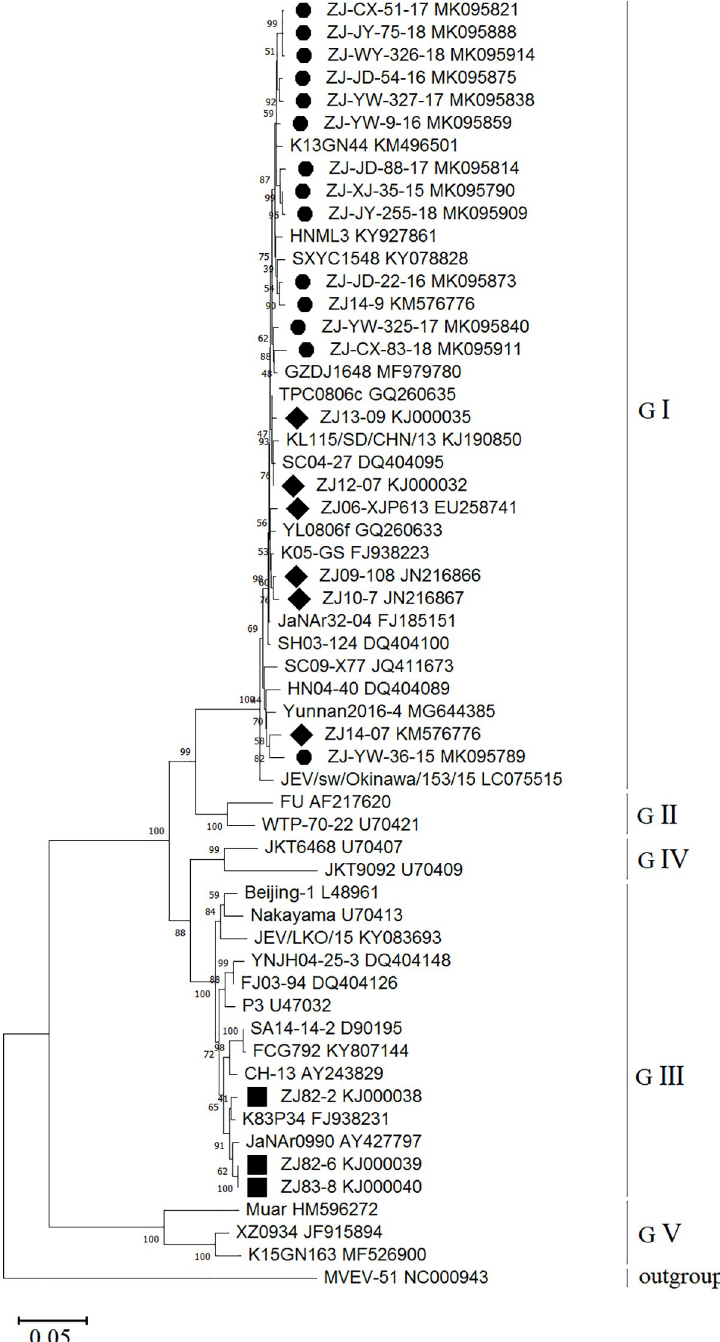
Fig 4. Phylogenetic tree on 1500-nt envelope gene of Japanese encephalitis virus strains. A total of 57 selected strains were involved in phylogenetic analysis, including 13 E gene samples (2015–2018), 10 strains (7 strains from 2006–2014 and 3 strains from 1982–1983) derived from Zhejiang Province and 34 strains derived from other provinces in China (Beijing, Fujian, Henan, Hunan, Guangxi, Gansu, Guizhou, Shandong, Shanghai, Shanxi, Sichuan, Taiwan, Tibet, Yunan) or abroad. The sequences of Zhejiang strains isolated in 1982–1983 and 2006–2018 are marked in black rhombus and circle, respectively. The virus name and Genbank accession number are noted. Phylogenetic analysis was performed by the maximum-likelihood method using MEGA 7.0 software package. Labels of strains conform to the following format: Strain name (including region and year of isolation) and GenBank accession number.